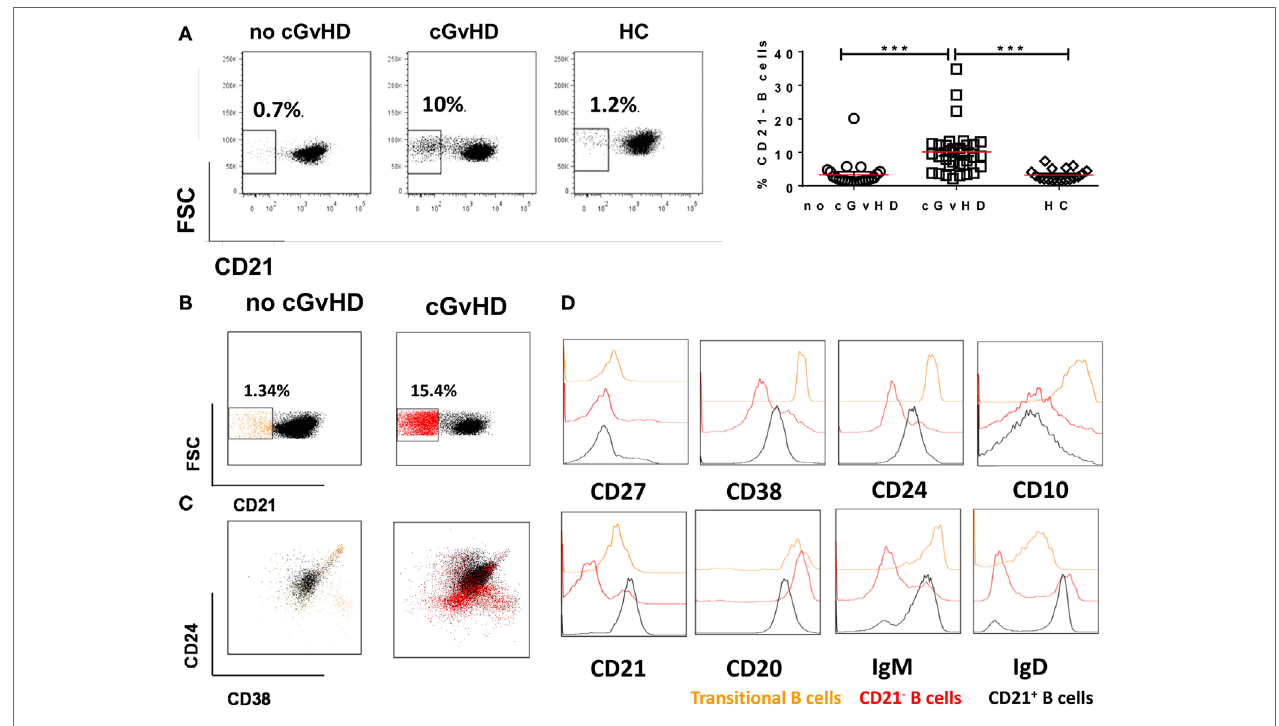
FigUre 2 | CD19 + CD21 − B cells in patients with or without chronic graft-versus-host disease (cGvHD) and healthy controls (HC). (a) FACS plots showing CD21 − B cell frequency in a representative “no GvHD” patient, GvHD patient, and a healthy control. Chronic GvHD patients ( n = 32) have significantly higher percentage of circulating CD21 − B cells compared with “no cGvHD” patients ( n = 23) and HC ( n = 18). (B,c) Color-coded gating on CD19 + B cells in representative “no GvHD” and active cGvHD patients; (B) cGvHD patient has higher frequencies of CD21 − B cells (red) compared with the “no cGvHD” representative patient (yellow). (c) Gated CD19 + B cells from the same examples are shown; the majority of CD21 − B cells in the “no cGvHD” group (yellow) fall within the CD24hiCD38hi transitional B cell and CD24 − CD38hi plasmablast regions. Conversely, the majority of CD21 − B cells in “cGvHD” patients (Red) fall within the CD24 − CD38 − exhausted B cell and CD24 − CD38hi plasmablast regions. (D) Phenotypic characterization of transitional (yellow) and exhausted CD21 − B cells (red) compared with CD21 + B cells (black) in a patient with